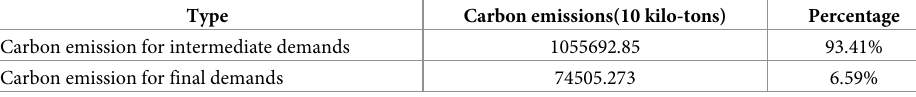
Table 5. Carbon emissions for intermediate and final demands in 2015.